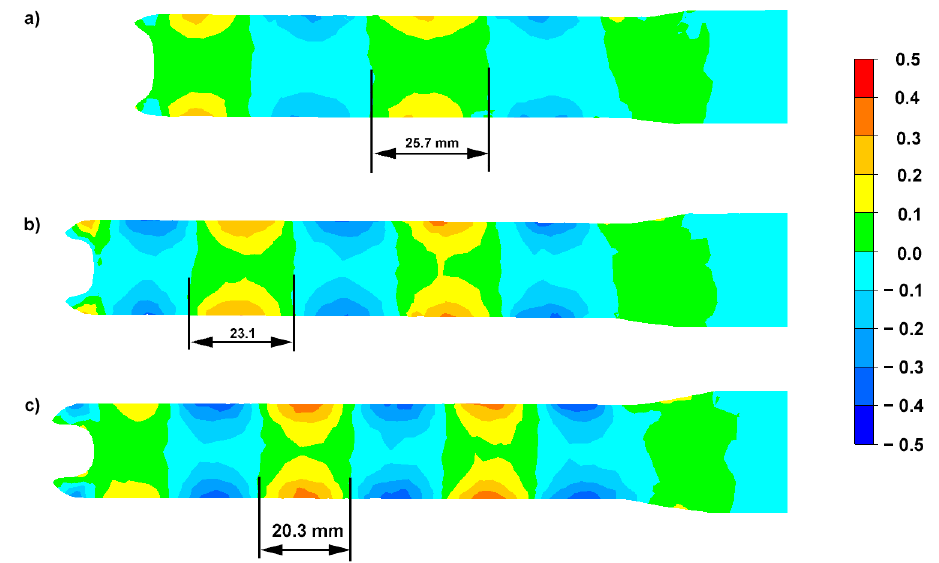
Figure 7. Distribution of the shear strain component γ ρz for the RSR process of AZ31 magnesium alloy bars: ( a ) Variant I, pass 3, ( b ) Variant II, pass 3, ( c ) Variant III, pass 2.